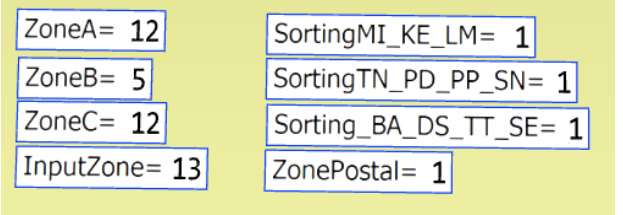
Figure 9. Current setting of the number of employees in the proposed variables.